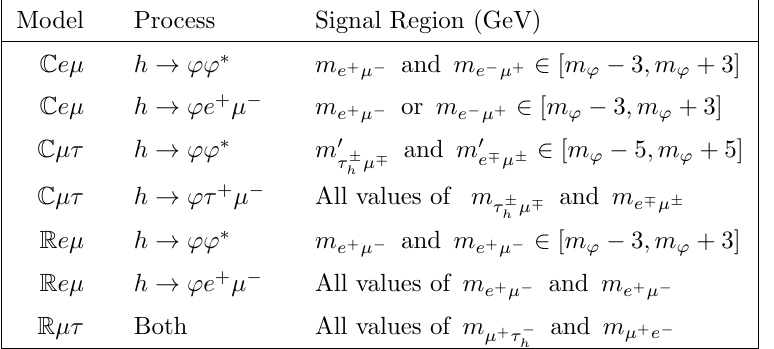
Table 5 . De(cid:12)nition of signal bins used to place limits on the branching ratios in each case. For the ossf events in model R e(cid:22) and R (cid:22)(cid:28) , we use the corresponding de(cid:12)nition from model C e(cid:22) and C (cid:22)(cid:28)